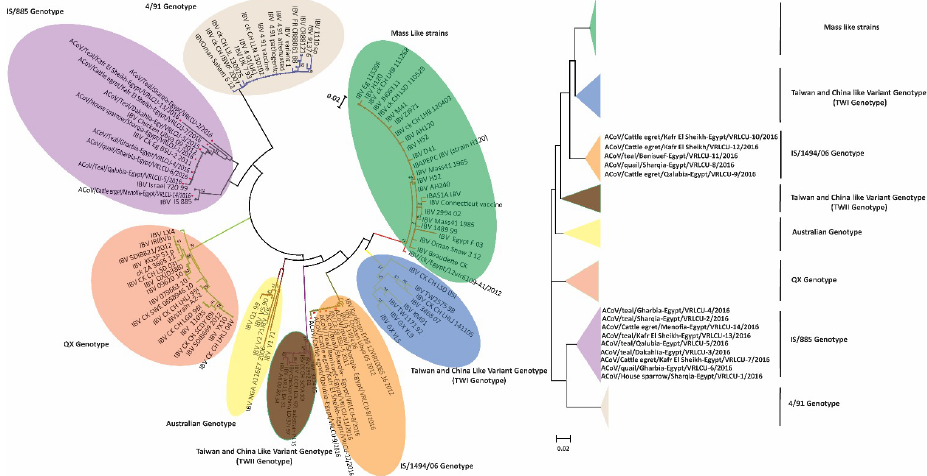
Figure 3. Phylogenetic tree based on S1 gene, showing the relationship between different ACoV genotypes worldwide in relation to ACoV isolates reported in this study (left panel-radiation tree; right panel-vertical tree). The robustness of individual nodes of the tree was assessed using 1000 replications of bootstrap re-sampling of the originally aligned nucleotide sequences. The scale bar represents the number of substitutions per site. The year of isolation and geographical origin of the virus sequences are included in the tree. Trees were constructed using maximum likelihood methods. The reported isolates in this study are marked with red